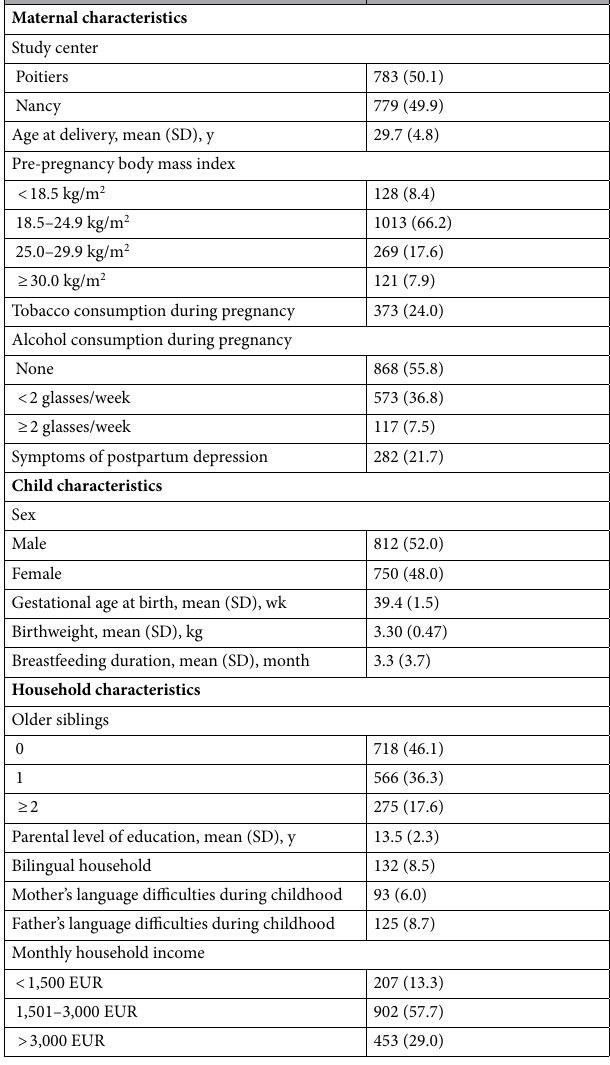
Table 1. Maternal, child and household characteristics of the participants from the EDEN cohort. a Unless otherwise indicated, data are number (percentage) of participants. b Data were missing for 31 participants (2%) for pre-pregnancy body mass index, 5 (0.3%) for tobacco consumption during pregnancy, 6 (0.4%) for alcohol consumption during pregnancy, 16 (1.0%) for symptoms of postpartum depression, 1 (0.1%) for birthweight, 1 (0.1%) for duration of breastfeeding, 3 (%) for older siblings, 22 (1.4%) for mother’s language difficulties, 131 (8.4%) for father’s language difficulties, 9 (0.6%) for household